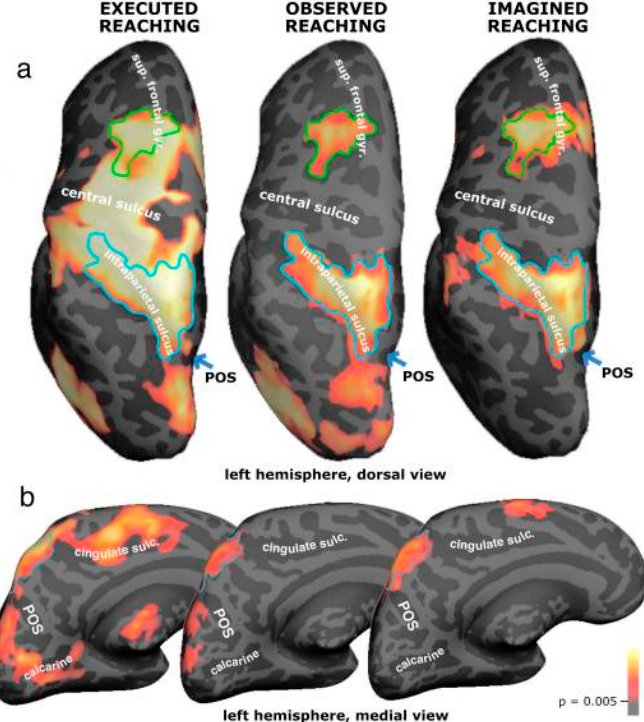
Figure 8. Overlap between executed, observed and imagined reaching in left dorsal premotor (superior frontal sulcus and gyrus) and left posterior parietal areas, on group surface-averaged activations from 15 subjects, displayed on one subject’s inflated hemisphere. The overlaps in premotor and parietal regions served as regions of interest in the percent signal change analysis. ( a ) Dorsal view of left hemisphere. ( b ) Medial view of left hemisphere. Executed, observed and imagined reaching all activated a medial parietal area located in between the parieto-occipital sulcus and the posterior end of the cingulate sulcus, outlined in light blue. Sup. frontal gyr. = superior frontal gyrus; POS = parieto-occipital sulcus; calcarine = calcarine sulcus; cingulate sulc. = cingulate sulcus. Reprinted with permission from ref. [100]. 2007. F. Filimon, et